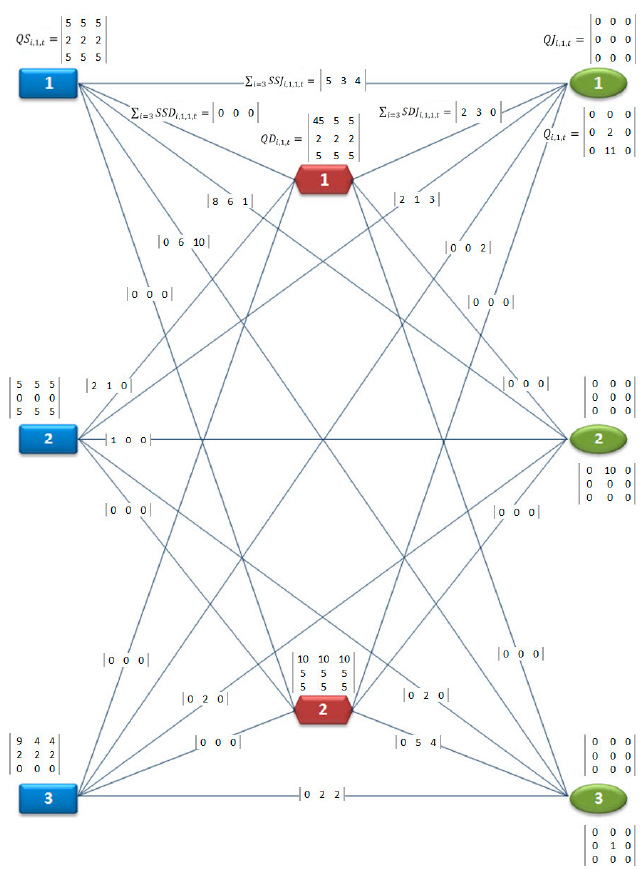
Figure 3. Inventory levels, shortages and shipments.